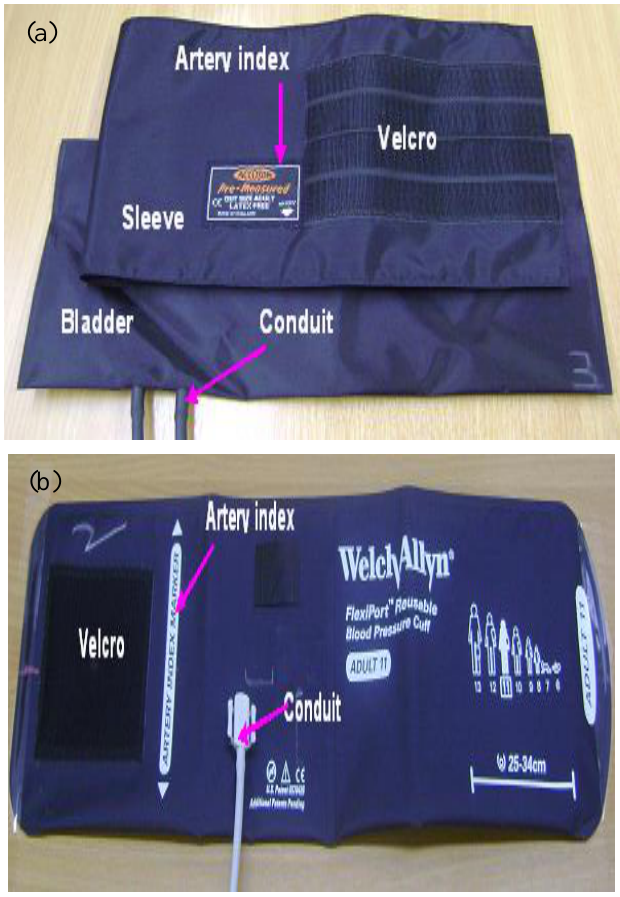
Fig. 1. BP measurement cuffs constructed from (a) four layers and (b) two layers of fabrics Five different types of commercially available cuffs were selected and then their specifications were determined using standard test methods. After that, pressure at the interface of the selected cuffs and a bare metal cylinder was noted against the pressure inside the cuffs, by mimicking phenomena of blood pressure measurement as per standard guidelines [11].